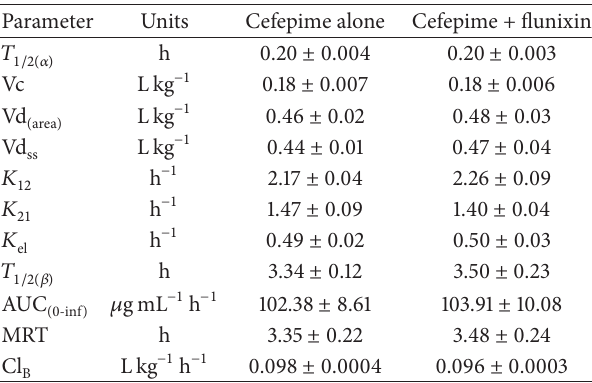
Table 1: Mean ( ± SE) kinetic parameters of cefepime (10mg/kg b.w.) alone and in combination with flunixin (2.2mg/kg b.w.) following a single intravenous injection in goats ( n = 6).